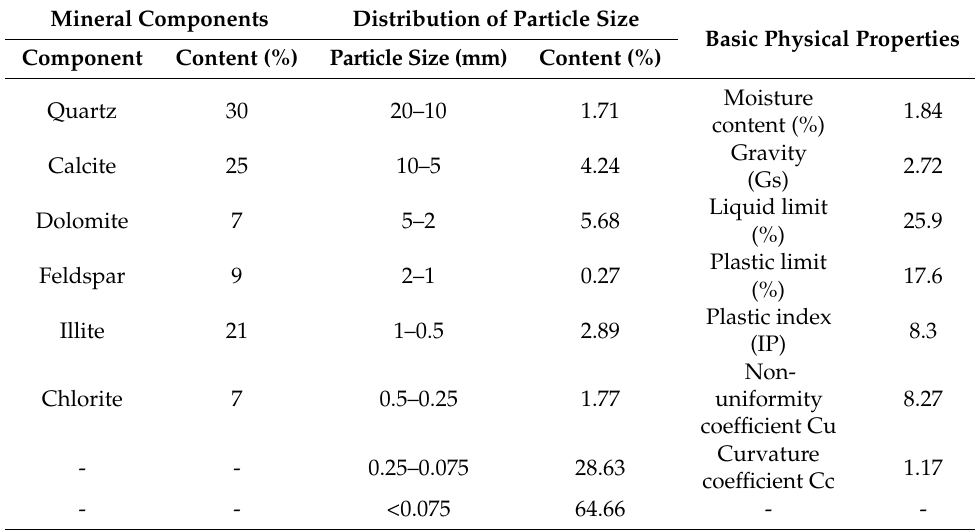
Table 1. Basic properties of test